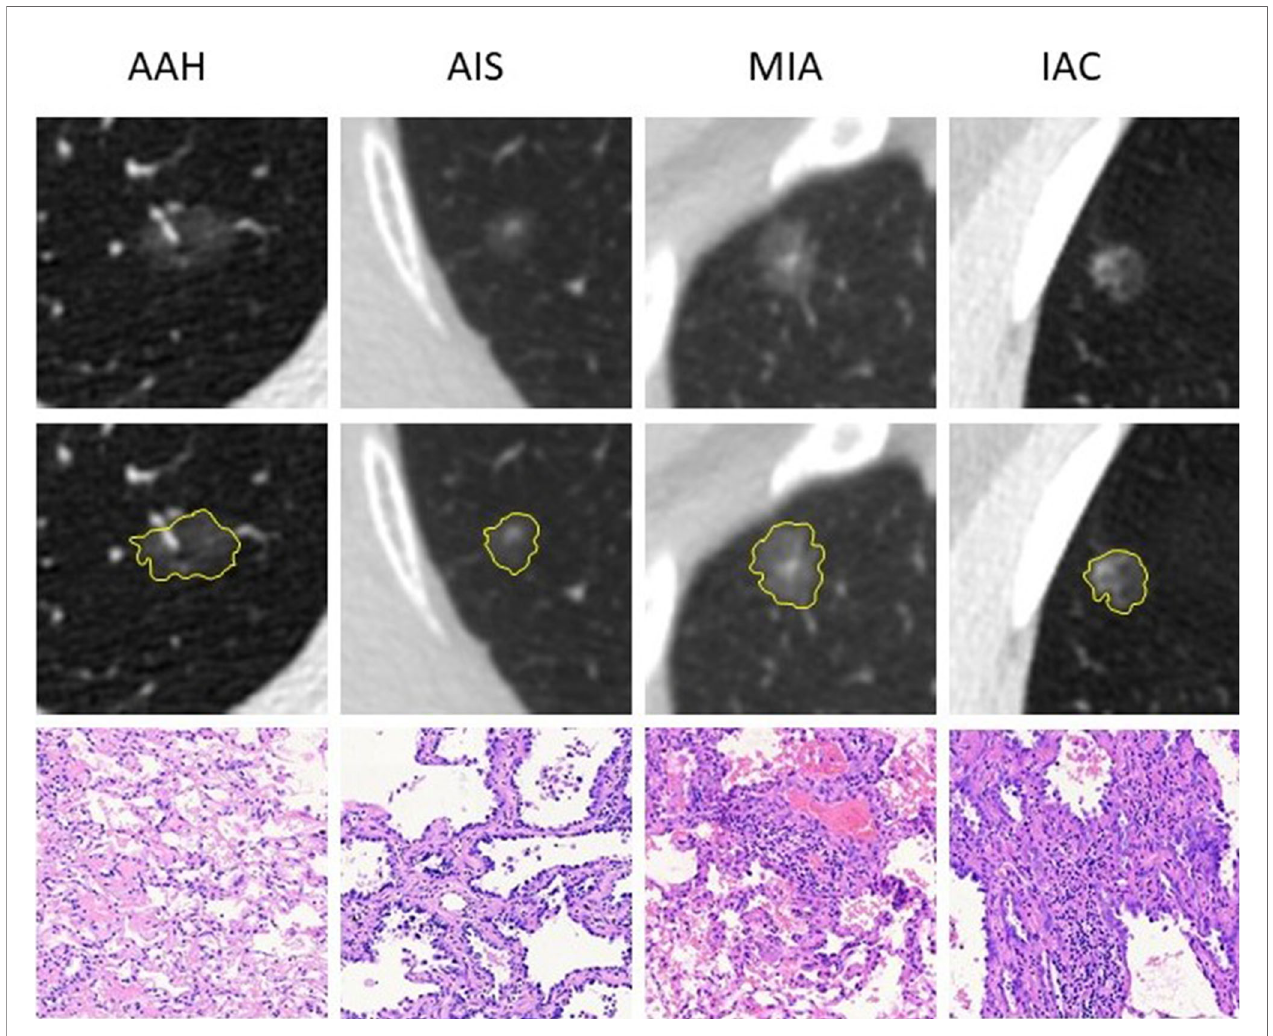
FIGURE 1 | Examples of the included nodules. The yellow shadow represents the shape of the lesions. The pathological pictures are from paraf fi n sections [hematoxylin and eosin (H&E), ×100 for AAH, AIS, and MIA; H&E, ×40 for IAC]. AAH, atypical adenomatous hyperplasia; AIS, adenocarcinoma in situ ; MIA, minimally invasive adenocarcinoma; IAC, invasive